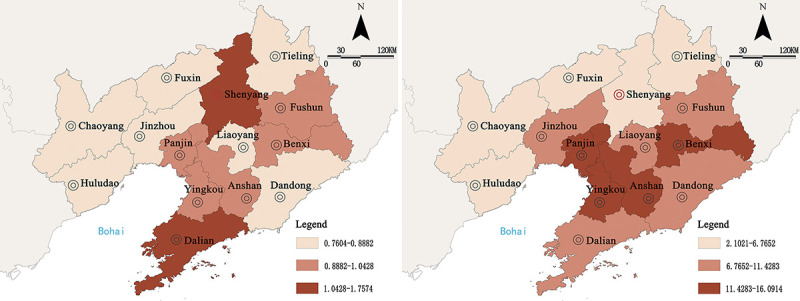
Spatial distribution diagram of geometric characteristics of LISA time path.a. Relative length. b. Curvature. (Source of base map: the open source map data service provided by the National Platform for Common GeoSpatial Information Services (https://www.tianditu.gov.cn/)).